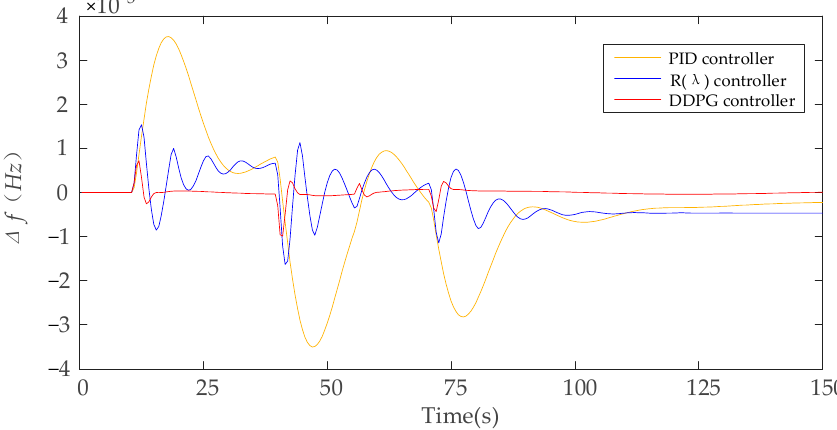
Figure 16. Performance of frequency control under load power disturbance. Figure 17. Performance of voltage control under load power Figure 17. Performance of voltage control under load power disturbance.